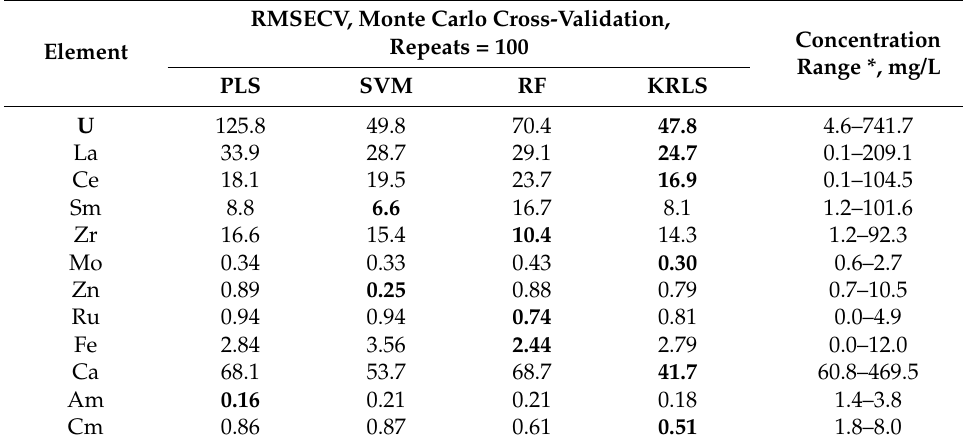
Table 1. RMSECV values for regression models obtained in Monte Carlo cross-validation. RMSECV, Monte Carlo Cross-Validation, Repeats = 100 Concentration Element Range *, mg/L PLS SVM RF KRLS U 125.8 49.8 70.4 47.8 4.6–741.7 La 33.9 28.7 29.1 24.7 0.1–209.1 Ce 18.1 19.5 23.7 16.9 0.1–104.5 14.3 1.2–92.3 Mo 0.34 0.33 0.43 0.30 0.6–2.7 Zn 0.89 0.25 0.88 0.79 0.7–10.5 Ru 0.94 0.94 Fe Ca 68.1 60.8–469.5 Am 0.16 0.21 0.21 0.18 1.4–3.8 Cm 0.86 0.87 0.61 0.51